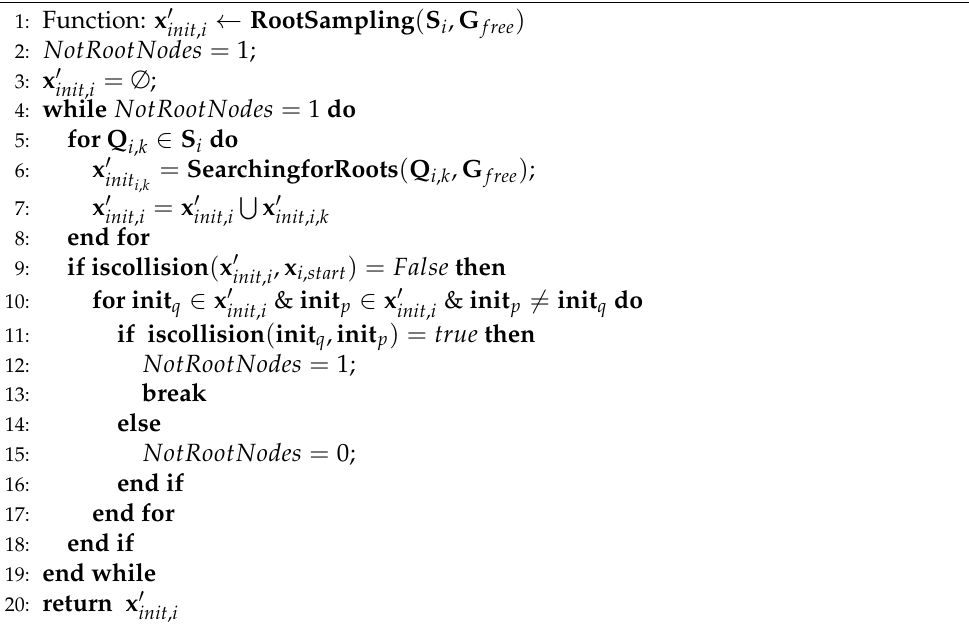
Figure 5. Path Reuse Schematic. Algorithm 2 Candidate tree nodes x (cid:48)